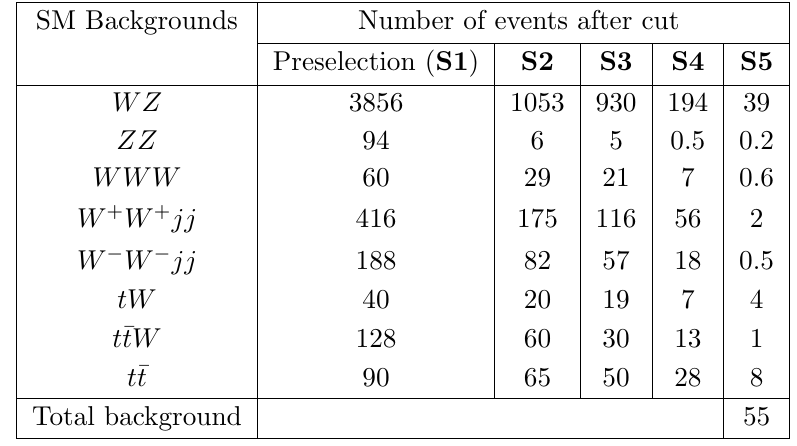
Table 12 . Same sign di-lepton + =E (cid:12)nal state number of events at 100 fb (cid:0) 1 for SUSY signals. T Note that the events have been rounded-o(cid:11) to the nearest integer where relevant. Cross-sections have been scaled using NLO K-factors obtained from Prospino .